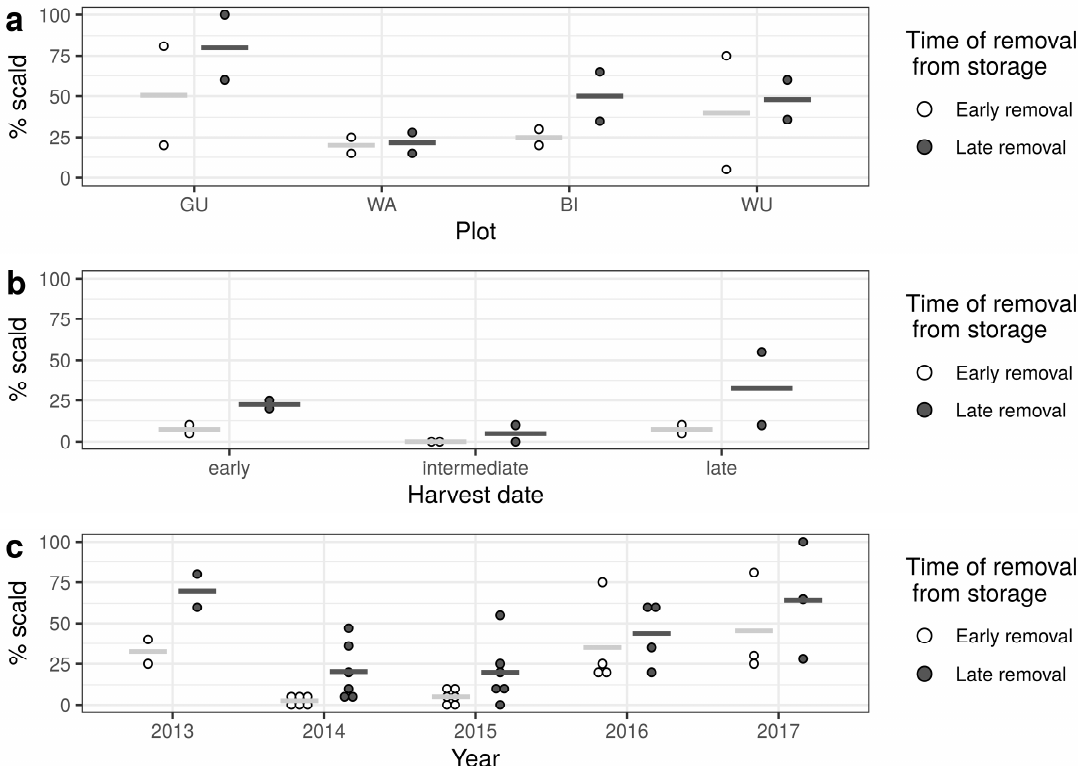
Figure 2. Preharvest factors influencing superficial scald development on Malus × domestica cv. Ladina. Percentage of superficial scald occurring in “Ladina” after 7 days “shelf life” at 20 ◦ C when removed from storage after 5 months (early removal) or after 7 months (late removal). ( a ) Percentage of symptomatic fruits in four locations and two growing seasons (2016 and 2017)); ( b ) Percentage of symptomatic fruits harvested at three di ff erent ripening degrees from two orchards in one location and one growing season (2015); ( c ) Percentage of symptomatic fruits from di ff erent growing seasons with fruits from all locations (2013 to 2018). All fruits displayed were stored under control conditions. The results of the statistical evaluations are displayed in Table 2. Dots represent measured data points and horizontal lines denoting the means.